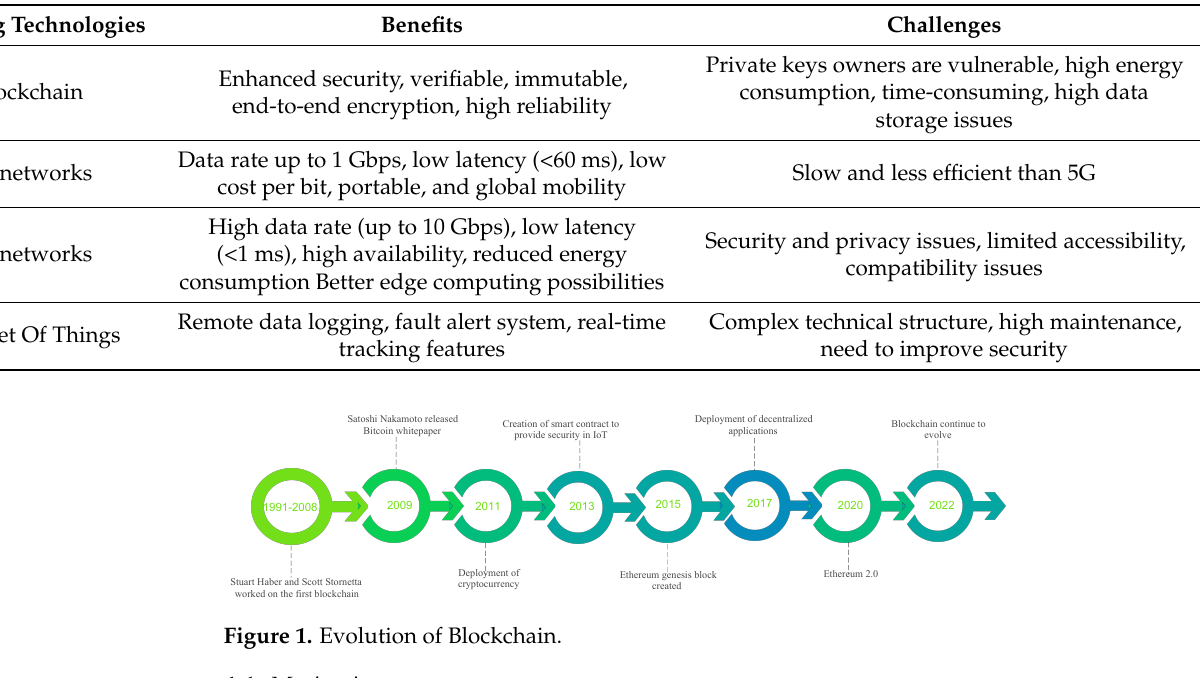
Table 1. Comparison analysis of several trending technologies.